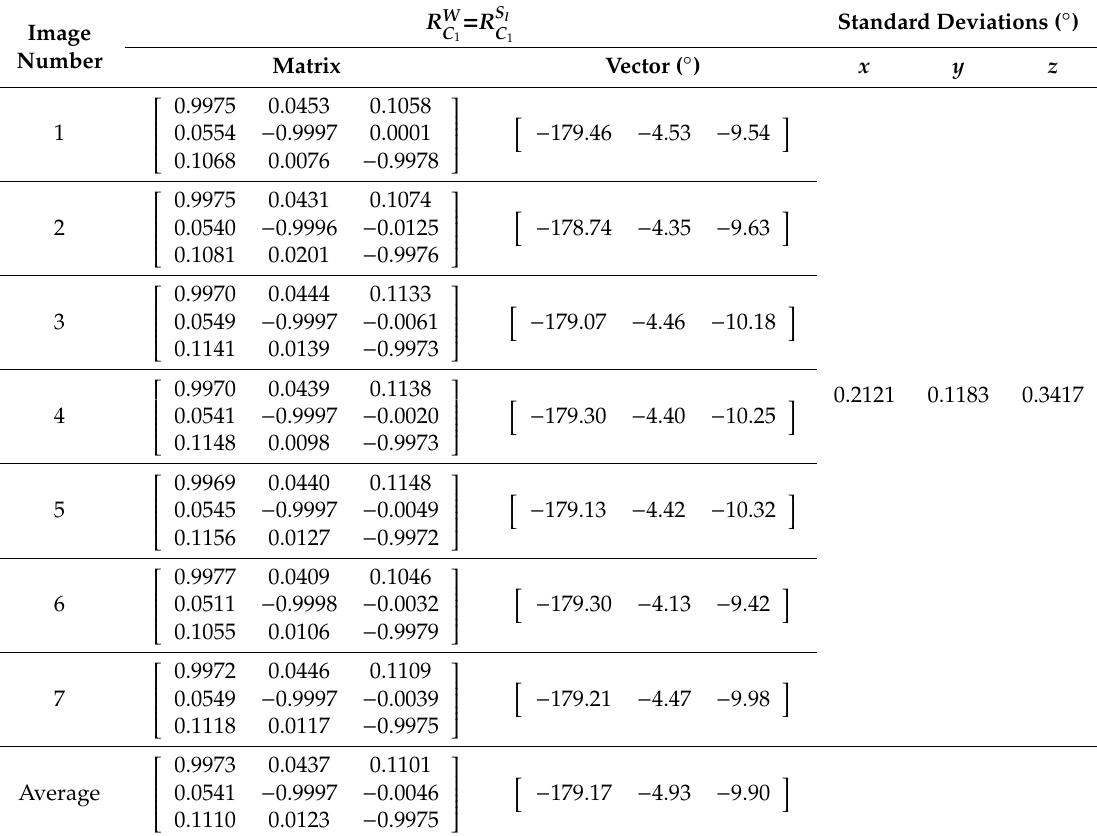
Table 3. Rotation matrices from the C 1 system to the W system.